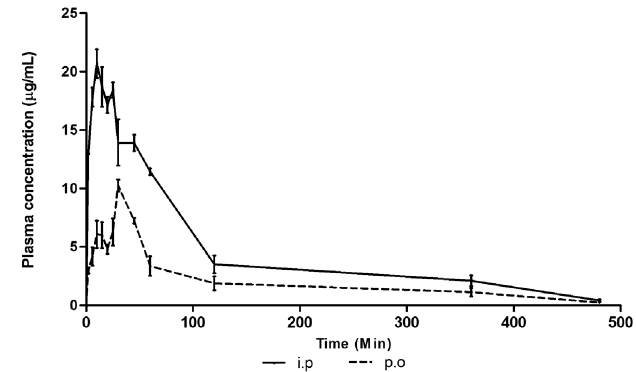
FIGURE 3 - Plasma concentration - time profile of 6-methylcoumarin after oral and intraperitoneal administration in Wistar